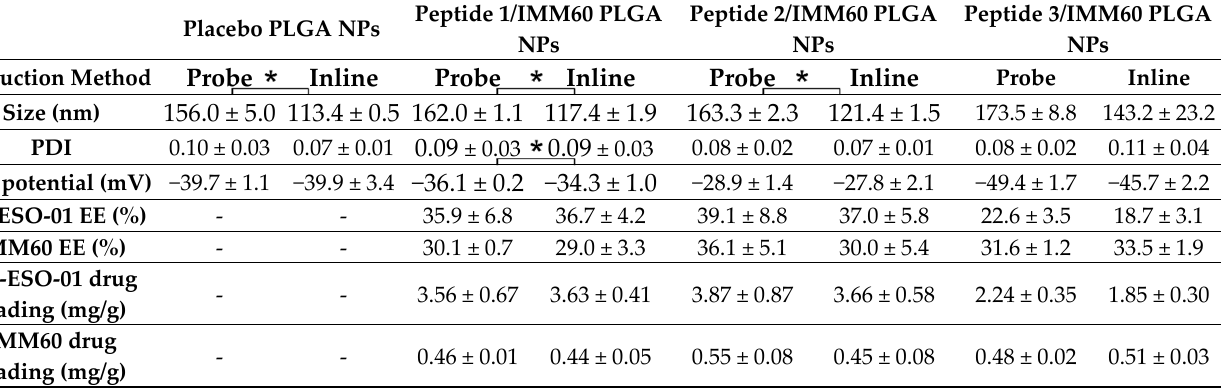
Table 4. Nanoformulation characteristics obtained via direct probe batch and indirect inline continuous mode. Significance of the difference among the compared groups was determined with regard to the production method.